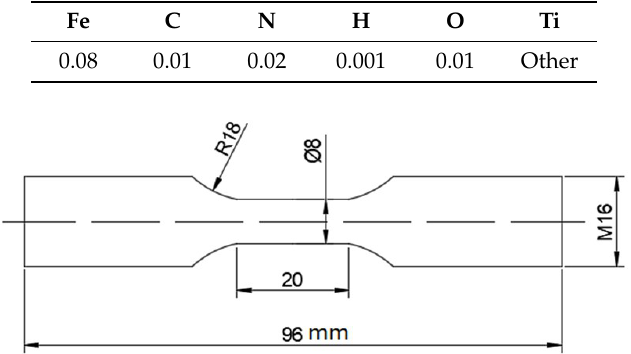
Table 1. Chemical composition of commercial pure titanium (CP-Ti) (weight %).